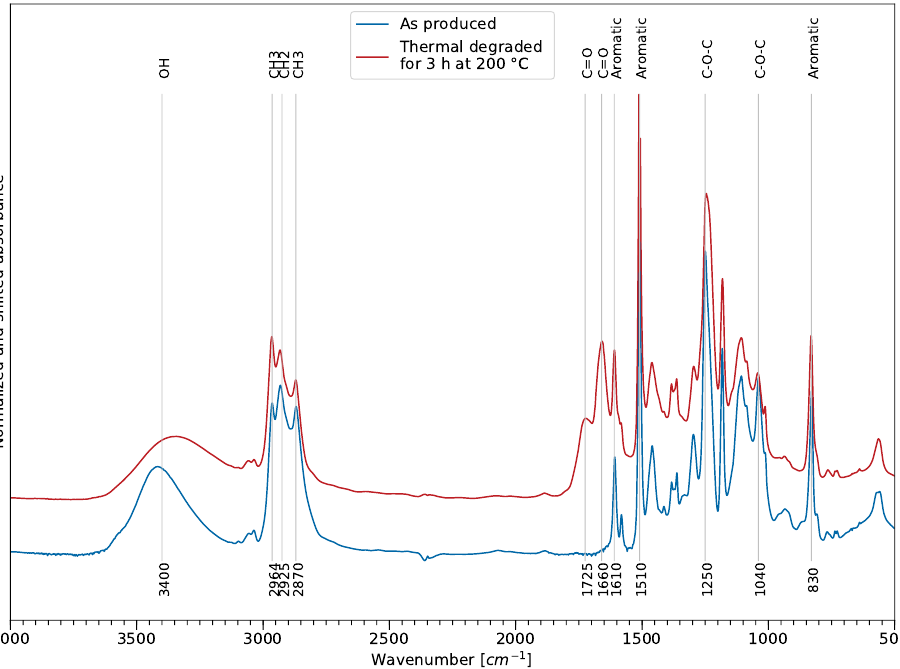
Figure 6. Overview of sensitivity of the FTIR bands to thermal exposure in the MIR spectral area (500 to 4000 cm − 1 ) for film samples.